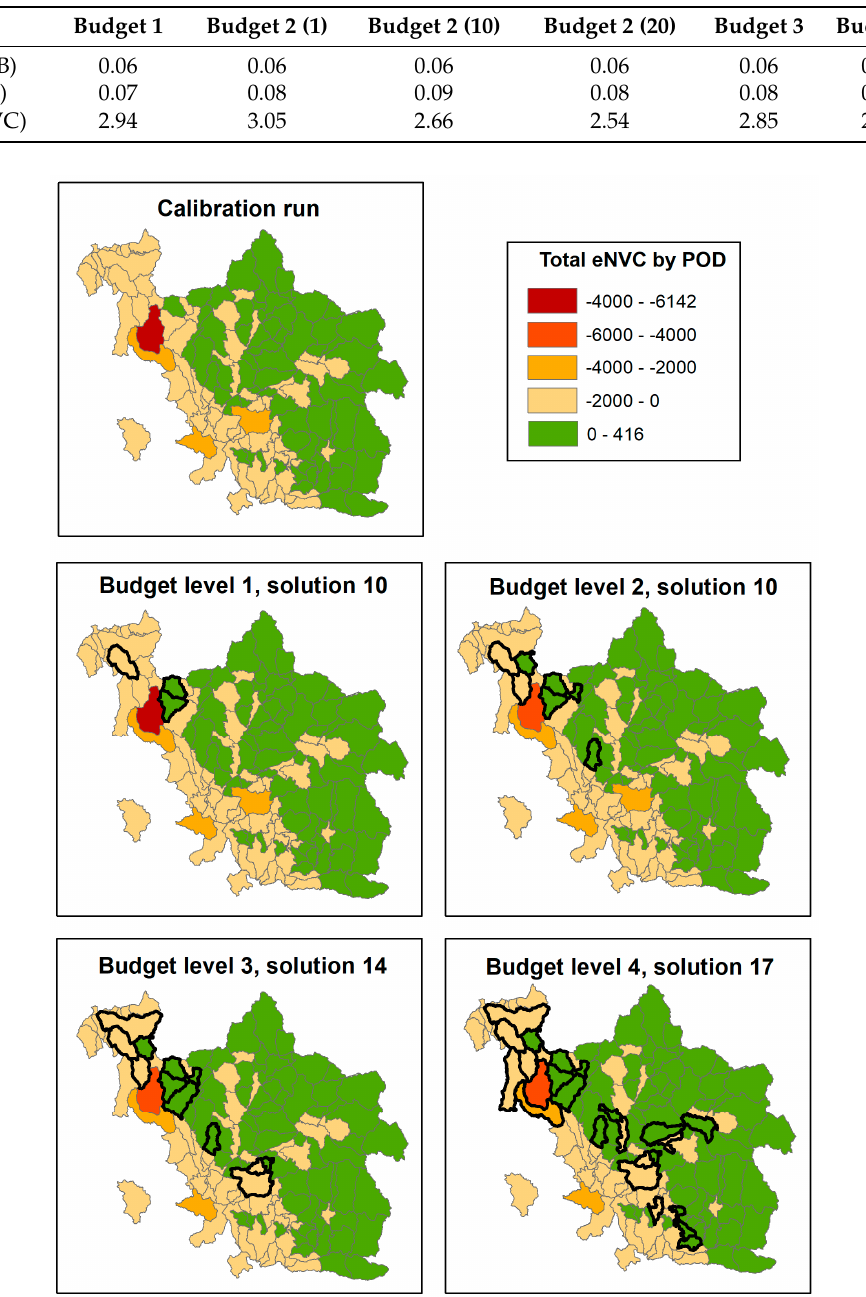
Figure 12. Total POD-level eNVC under the existing conditions (calibration) landscape, as well as four treatment scenarios. Black outlines indicate treated PODs.